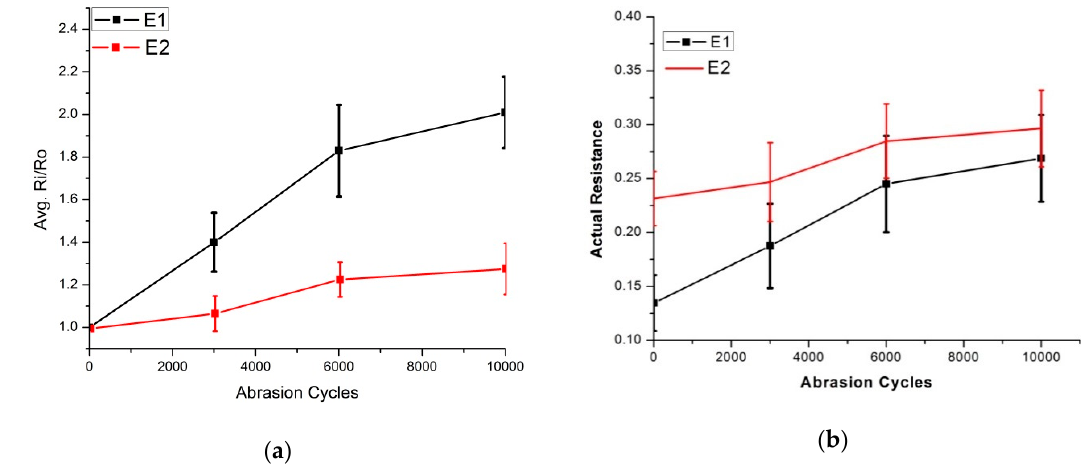
Figure 14. Surface resistance analysis after abrasion cycles, four samples of each electrode were tested, ( a ) Comparison of Ri/Ro ( b ) comparison of actual resistance.